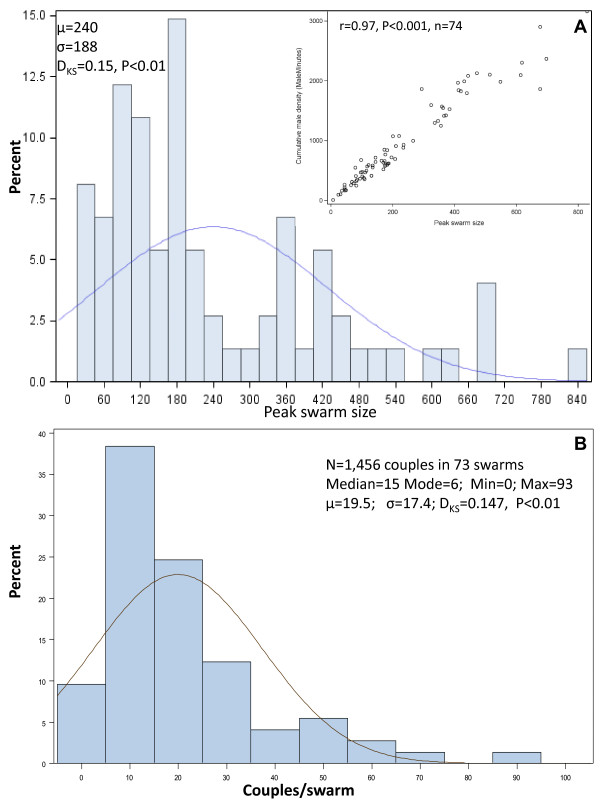
Distributions of peak swarm size (A) and the total number of couples per swarm (B). Normal density curves are depicted based on the data means and standard deviations. The results of the Kolmogorov-Smirnov (KS) tests are reported under the mean and standard deviation. Panel A inset: Relationship between peak swarm size and cumulative swarm size (excluding swarms which were not observed throughout).